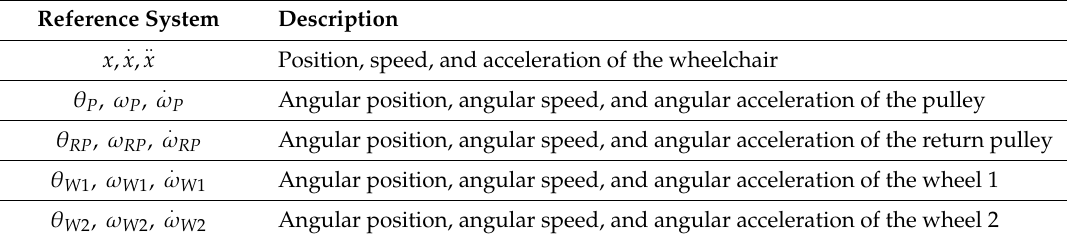
Table 4. Reference system’s dynamic